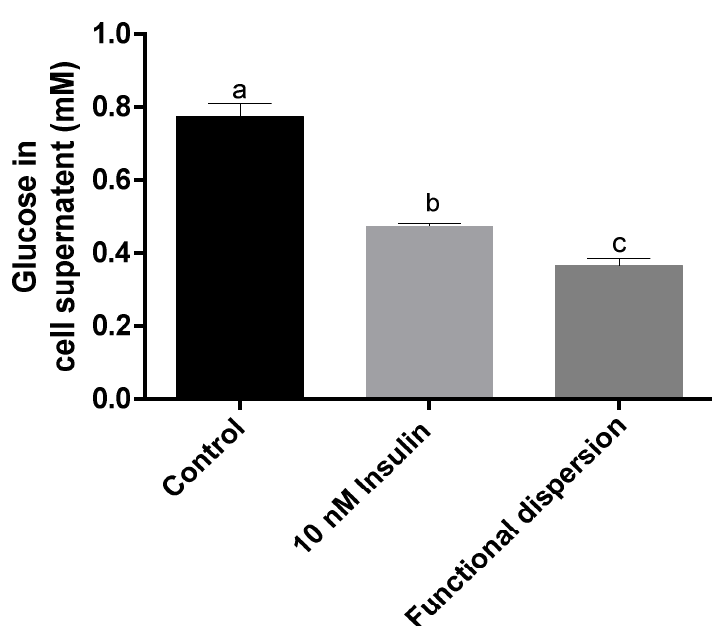
Figure 6. The amount of glucose in the cell supernatant of rat L6 skeletal muscle cell lines alone as control, and treated with 10 nM insulin and functional dispersion for 24 h. Means with different letters are significantly different at p < 0.05 calculated using the two-tailed unpaired t -test. All data are represented as the mean ± S.D. of triplicates.